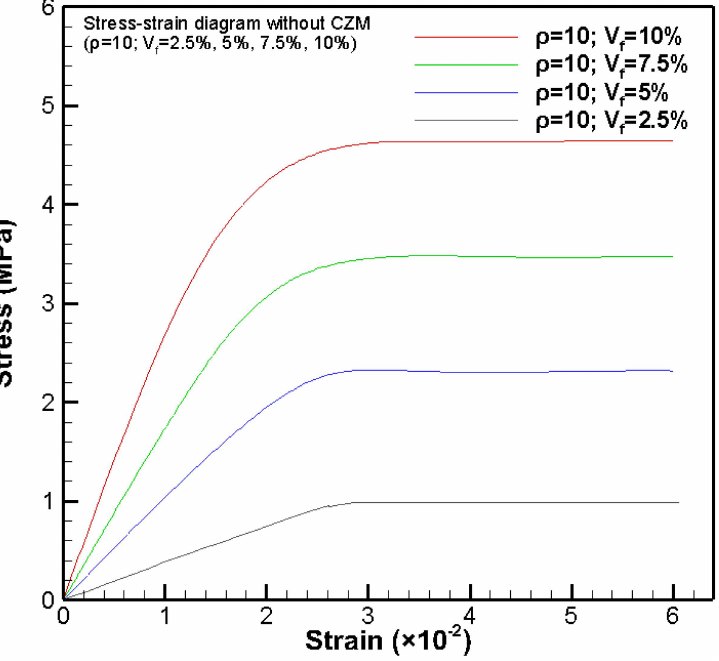
Figure 17. Effective stress-strain diagrams of the PNC (stack nanoparticle configuration) without CZM at the nanoparticle volume fraction of V f = 2.5%, 5%, 7.5%, and 10%, respectively ( ρ =